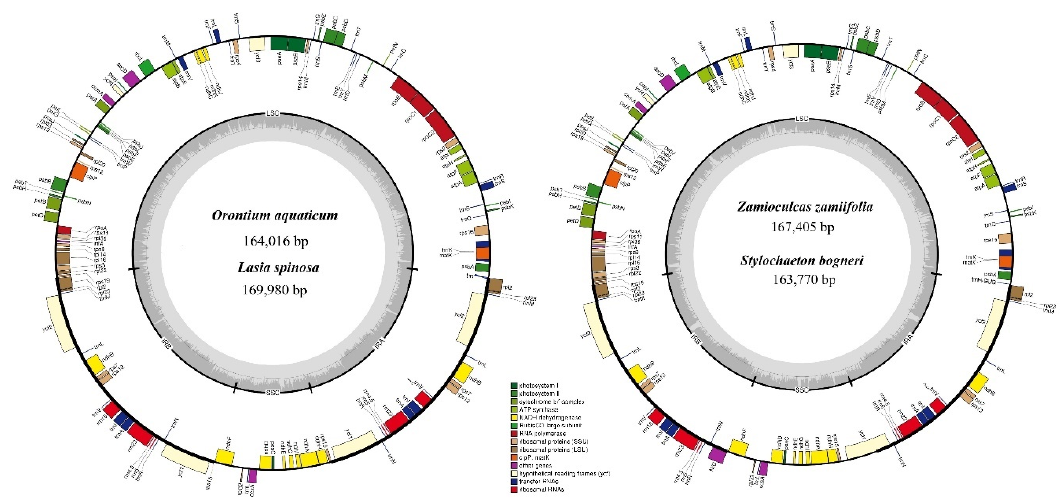
Figure 2. Circular maps of chloroplast genomes. Genes present inside the circle are transcribed counter-clockwise, whereas genes present outside the circle are transcribed clockwise. Genes are color-coded based on functionality. LSC, IRb, SSC, and IRa of the inner circle represent quadripartite structure of genomes.